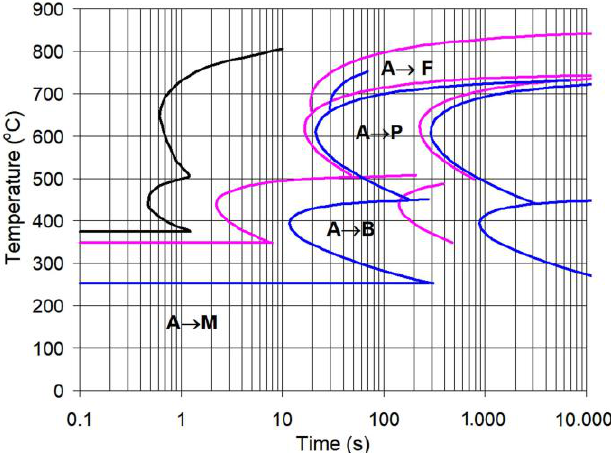
Figure 2. TTT diagrams for steel austenitized at 770 °C (blue lines) and 900 °C (pink lines). The lines correspond to the start (0.1 vol. %) and finish (99.9 vol.%) of the transformation. The black line refers to (Cr, Mo, and V)-free steel (T A = 900 ◦ C) (A, F, P, B, M are austenite, ferrite, pearlite, bainite, and martensite,